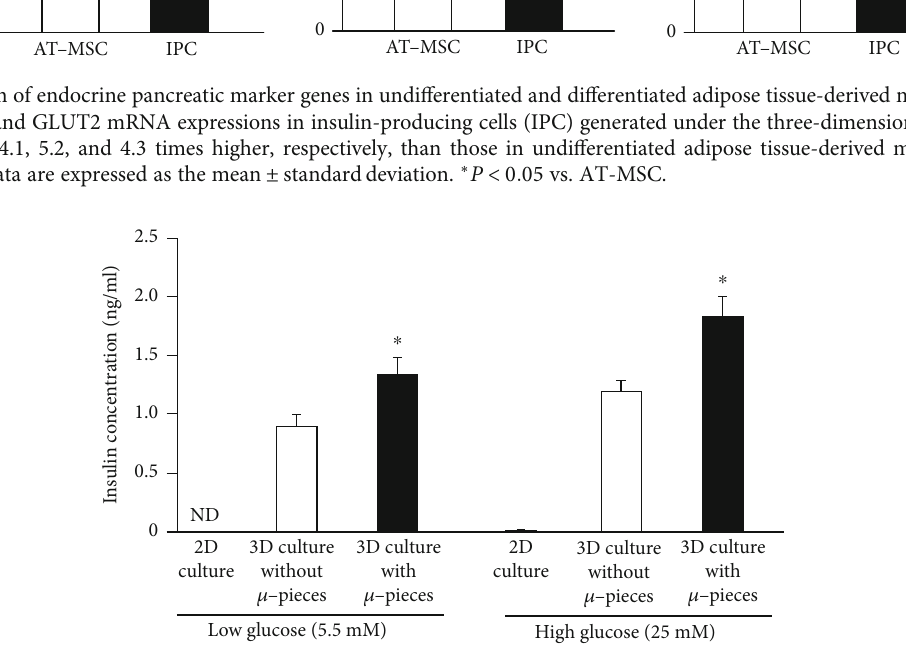
Figure 3: In vitro insulin release in response to glucose stimulation. The insulin secretion ability under glucose stimulation was higher in the IPCs generated by the 3-dimensional (3D) culture system with μ -pieces than in cells cultured without μ -pieces. Data are expressed as the mean ± standard deviation . ∗ P < 0 : 05 vs. 3D culture without μ -pieces. ND: not detected.